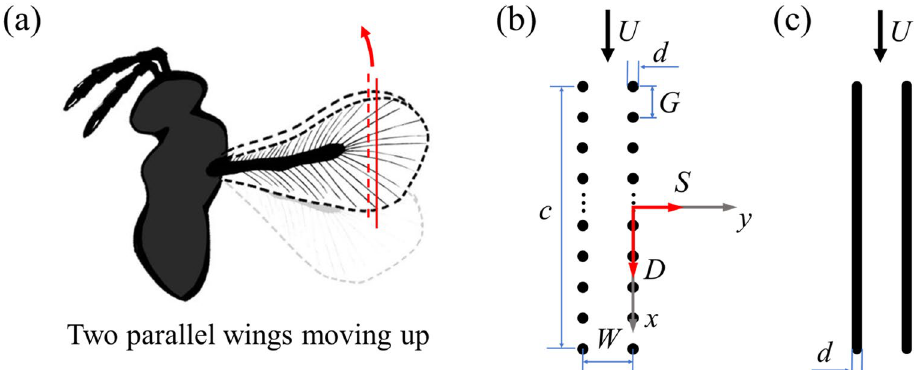
Figure 1. ( a ) Bristle wings are modeled in two dimension using a cross section through the chord of two wings. The red arrow represents the direction of movement of the wings. This diagram was drawn by using the software Procreate (version:5.2.5) on the iPad. ( b ) Two bristled wing models at distance of W are placed in uniform incoming flow of velocity U . ( x , y ) are coordinates in a system with its origin at the center of the wing chord c . The variables G and d represent the diameter of the bristle and the distance between two adjacent bristles, respectively. Side force ( S ) and drag ( D ) are the horizontal and vertical component of the aerodynamic force, respectively. ( c ) Two flat-plate wing models with thickness of d are placed in uniform incoming flow of velocity U